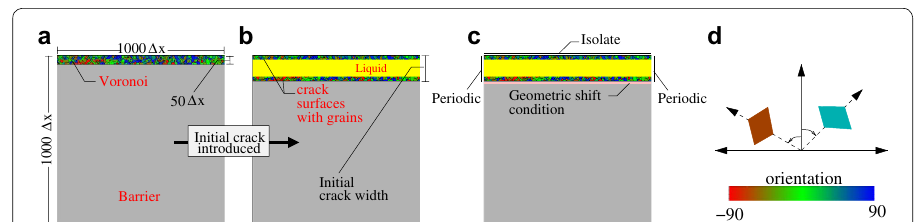
Fig. 3 a Dimensions of the computational domain consisting of a layer of polycrystalline grains (in RGB colors) generated using voronoi diagram and the stationary barrier phase (in gray). b An initial crack filled with liquid (in yellow) is introduced. c The applied boundary condition at the edges of